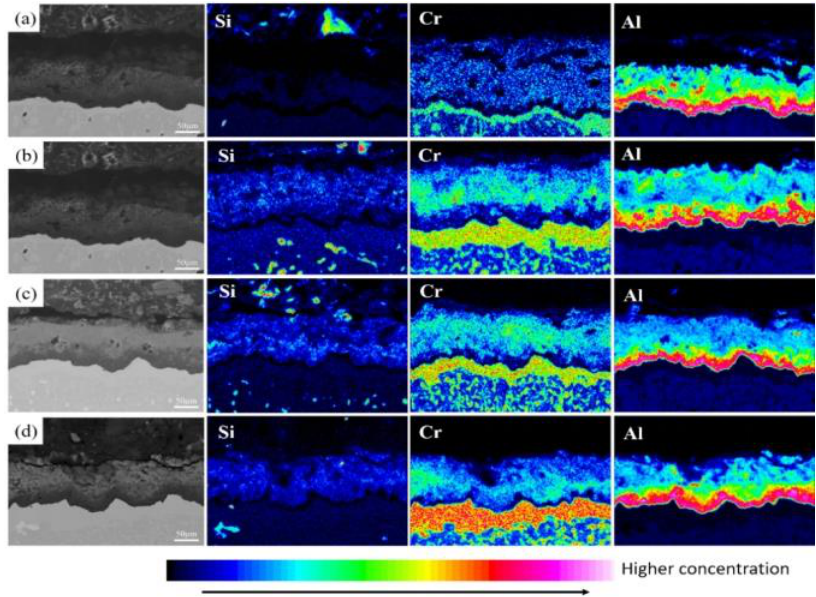
Figure 20. Element distribution of Al-Si coating at 1000 °C constant temperature oxidation for 300 h with different pre-oxidation times: ( a ) 3 h; ( b ) 5 h; ( c ) 7 h; ( d ) 9 h.